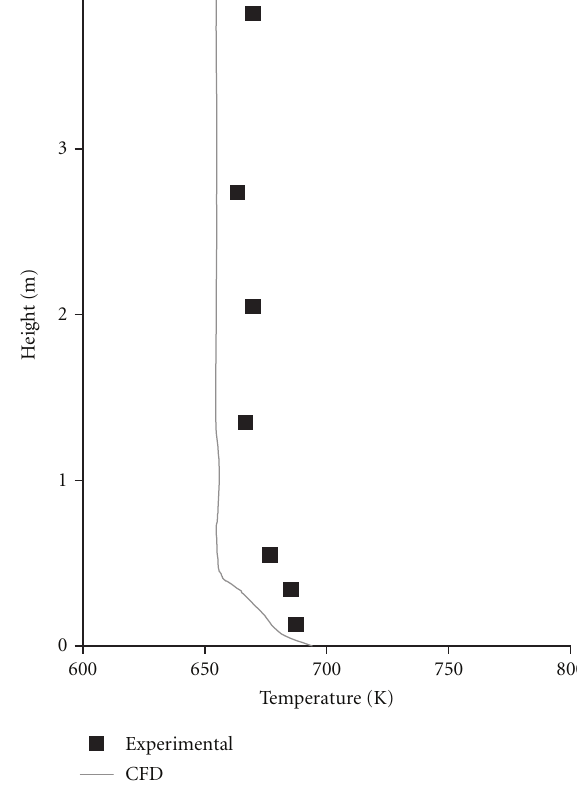
Figure 9: Time-averaged gas phase temperature profile at the axial central position in the riser compared with the experimental